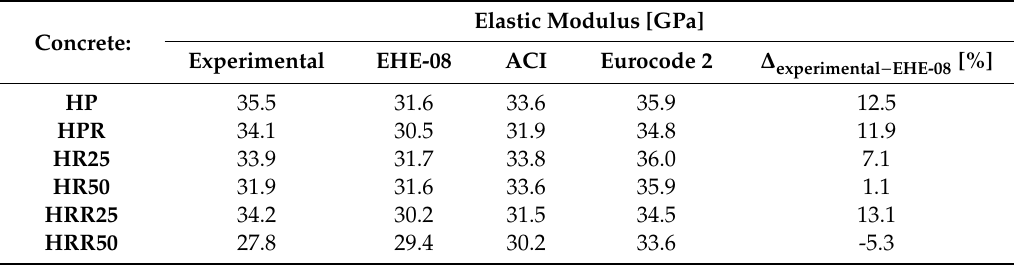
Table 5. Elastic modulus obtained with different expressions.